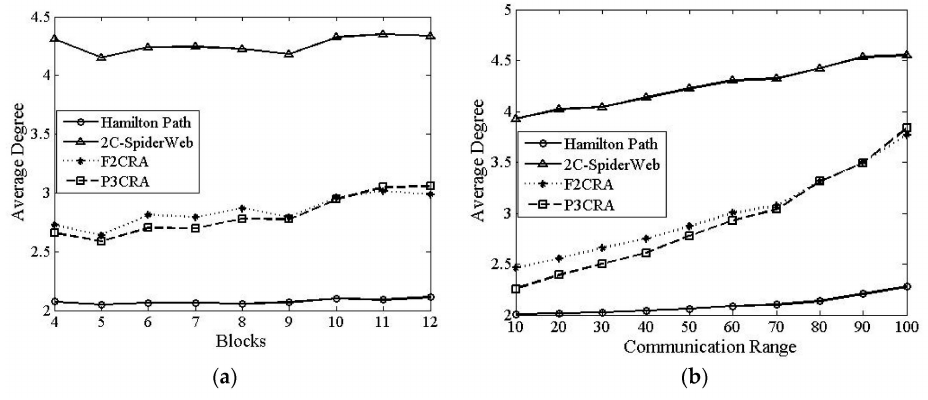
Figure 9. ( a ) Average Degree vs. Segments; and ( b ) Average Degree vs. Communication